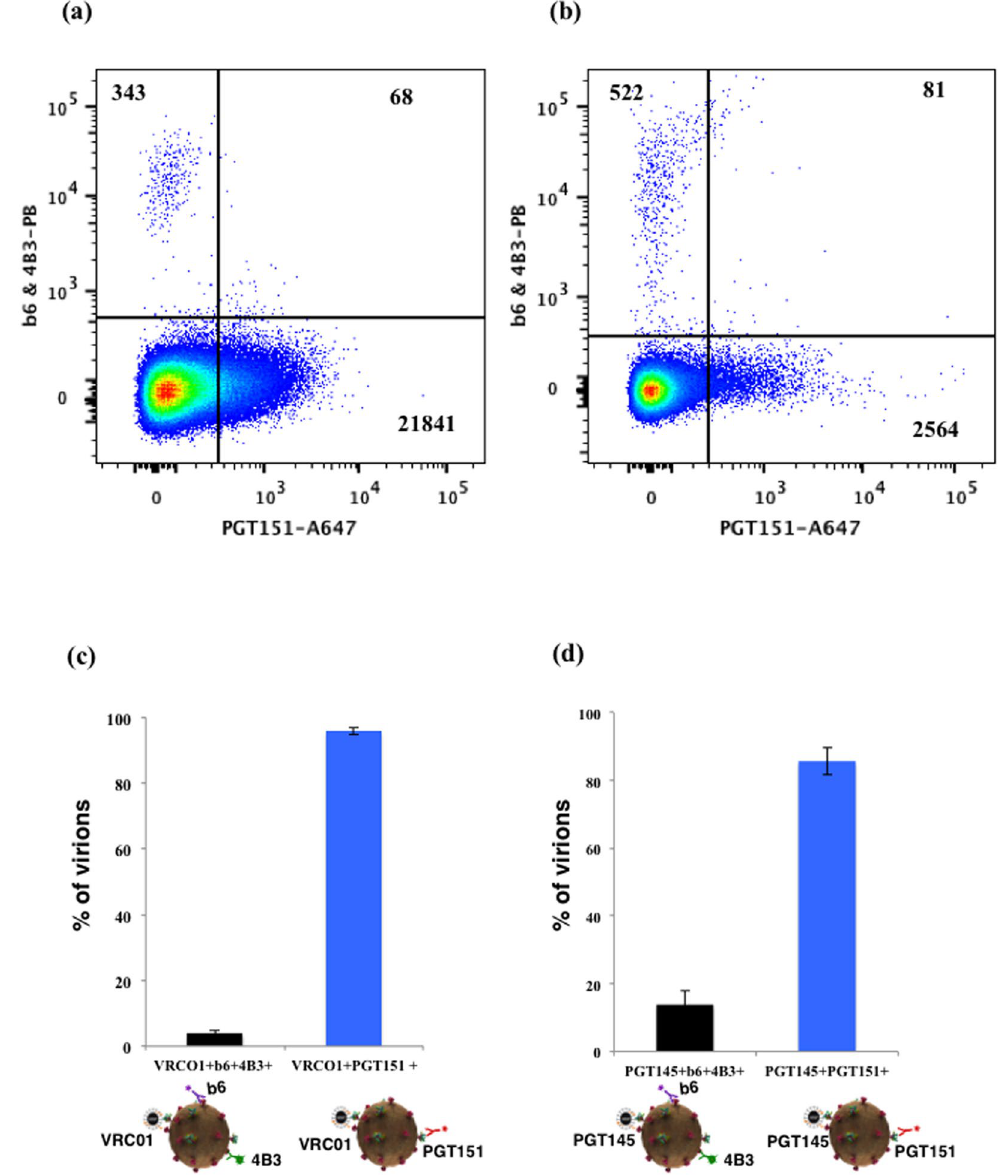
Figure 6. Flow virometry of T/F HIV-1 CH162 virions. ( a , c ) Distribution of VRC01-MNPs–captured virions stained with three antibodies: AlexaFluor 647-labeled PGT151, Pacific Blue-labeled b6 and 4B3. Each bar represents mean ± SEM of three experiments. ( b , d ) Distribution of PGT145-MNPs–captured virions stained with three antibodies: AlexaFluor 647-labeled PGT151, Pacific Blue-labeled b6 and 4B3. Each bar represents mean ± SEM of three